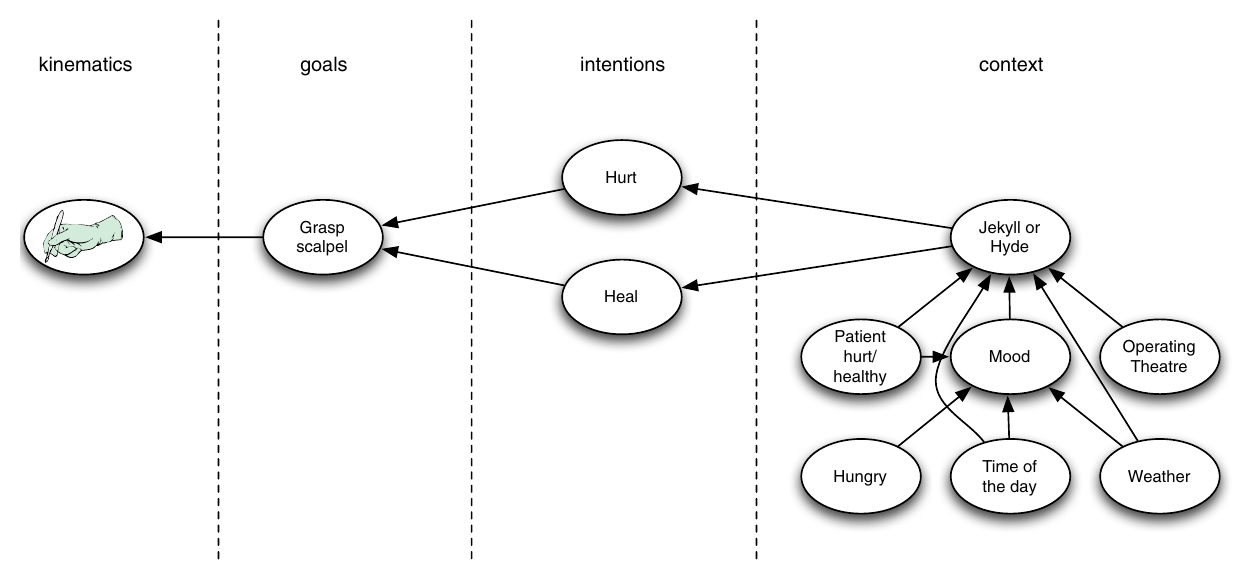
depend on a myriad of interconnected variables, such as the present location, the health status of the patient, the weather, and the person’s mood. Note that this complexity cannot be dissolved by decomposing the complex causal model into simple causal models at higher levels of the hierarchy, because complex models cannot generally be so decomposed. So it seems that if one wants to use the hierarchical predictive coding framework to explain high-level cognition, then complex models within levels